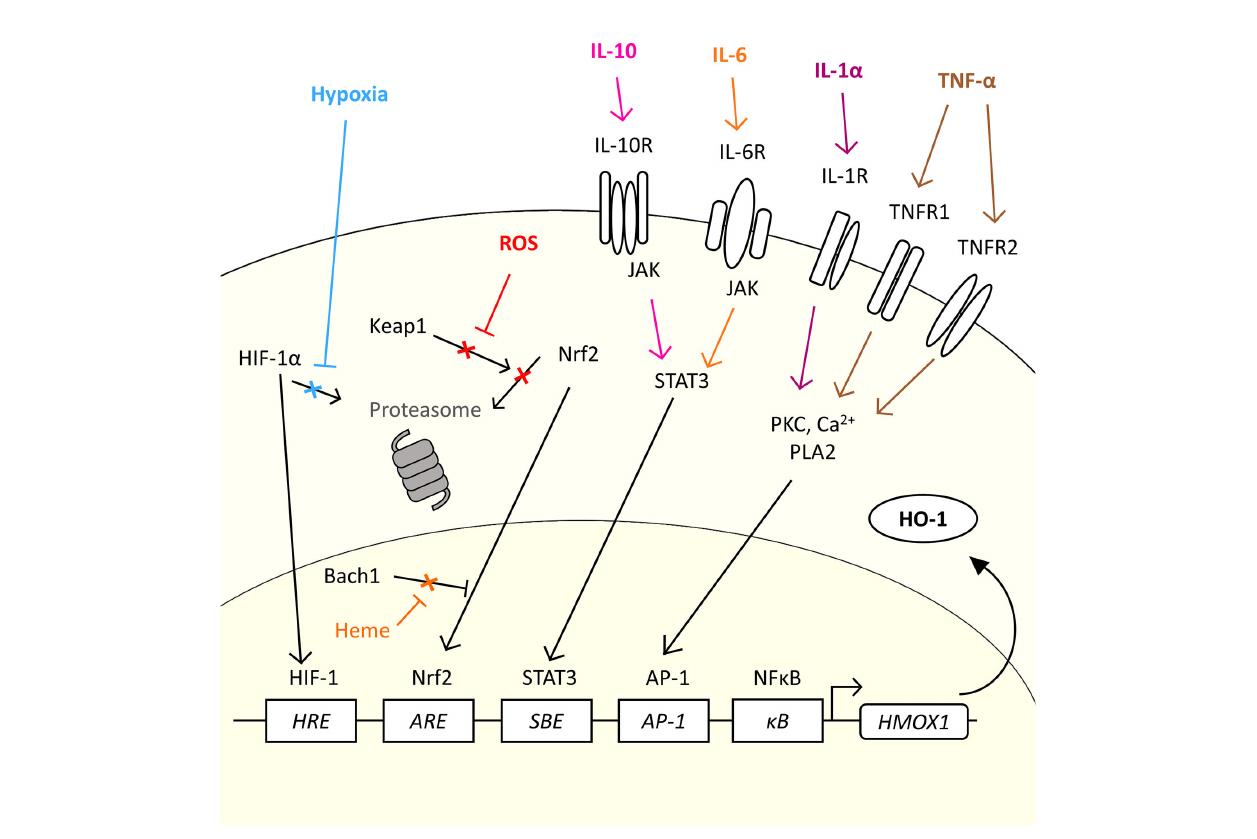
FIGURE 2 | The diverse range of signals in the TME which could induce HMOX1 expression. HMOX1 mRNA expression is induced by a range of molecular and physical signals. The fi gure highlights common physical characteristics (hypoxia), metabolic by-products (ROS) and cytokines commonly associated with the TME which could induce the expression of HO-1 in cancer. In normal conditions, the transcription factor Nrf2 is inhibited by Keap1 which prevents nuclear translocation and promotes its proteasomal degradation. ROS generated by oxidative stress inhibit the interaction between Keap1 and Nrf2, allowing Nrf2 to translocate to the nucleus and bind to the ARE of the HMOX1 gene. In the presence of heme, Bach1 is prevented from inhibiting Nrf2 access to the ARE allowing the expression of HMOX1 . Under conditions of hypoxia, the transcription factor HIF-1 a escapes proteasomal degradation and translocates into the nucleus where it forms a complex with HIF-1 b and binds to HRE to up-regulate HMOX1 gene expression. Cytokines such as IL-10 and IL-6 can induce expression via the JAK/STAT3 pathway, while IL-1 a and TNF- a induced HMOX1 expression through a PKC, Ca 2+ signaling, and PLA2 dependent pathway and AP-1 element in the promoter